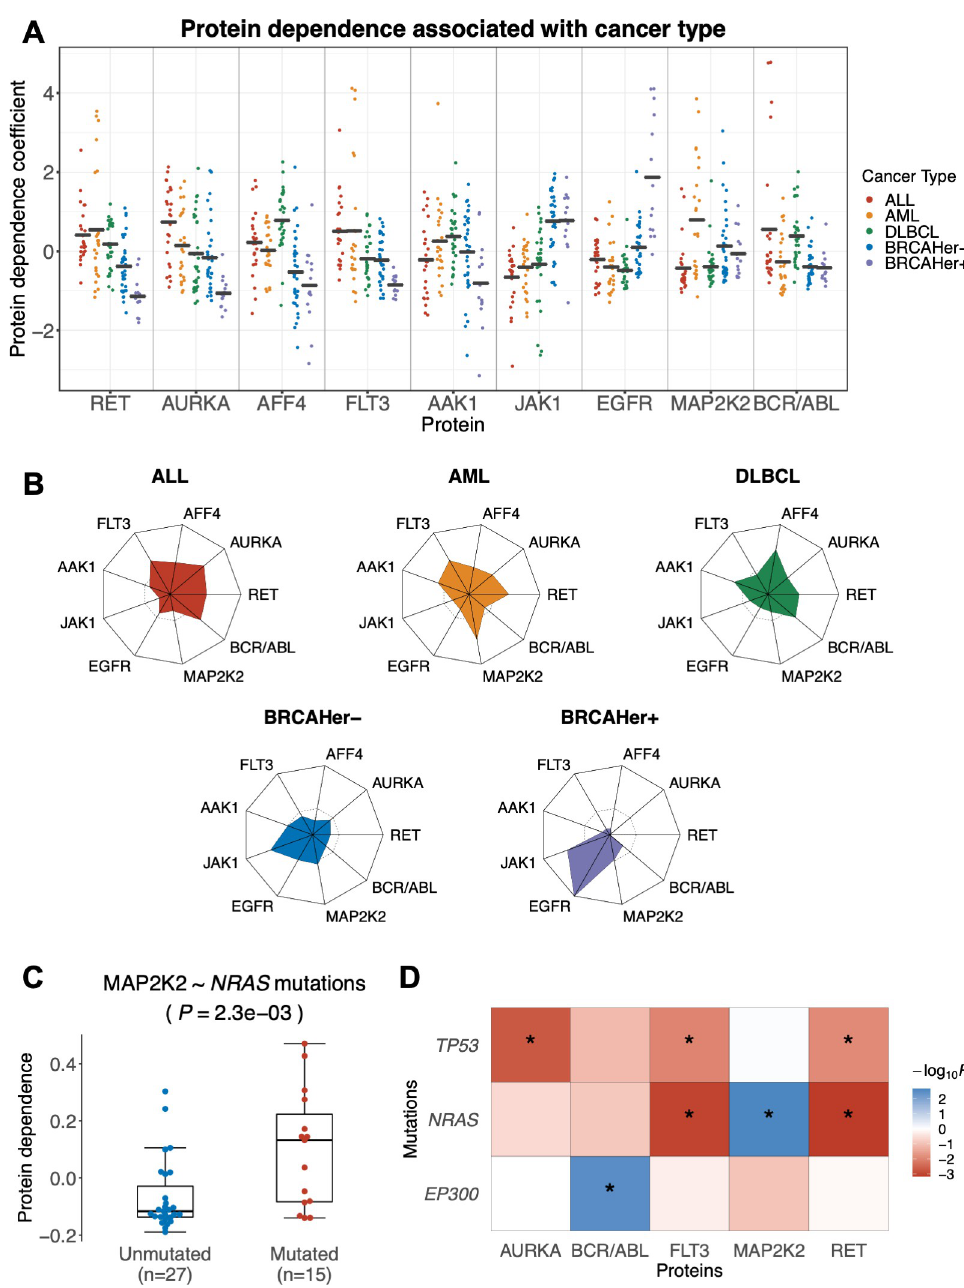
Fig 2. Results of protein dependence inference on the GDSC dataset. ( A ) Shown are the data for nine kinases for which we found significant differences in the protein dependence coefficients between cancer types (one-way ANOVA, BH adjusted p-value < 0.05, Fold Change > 0.1). Within each panel, each point corresponds to a cell line. The coefficients were centered and scaled to obtain a per-protein z-score, and the points are grouped and colored by cancer type (ALL, red; AML, orange; DLBCL, green, BRCAHer-, blue; BRCAHer+, purple). ( B ) Radar plots of protein dependence coefficients across the different cancer types. Dashed line represents a protein dependence coefficient of zero. ( C ) Association between NRAS mutation status and MAP2K2 dependence. Association testing was performed using Student’s t-test (two-sided, with equal variance). ( D ) A heatmap showing the -log10( P -values) with signs determined by direction of fold changes of the associations between mutational background of the cell lines and protein dependence coefficients (Student’s t-test). Blue: associations with higher dependence coefficients in mutated cases; red: lower dependence coefficients in mutated cases; stars indicate the associated pass 10% FDR